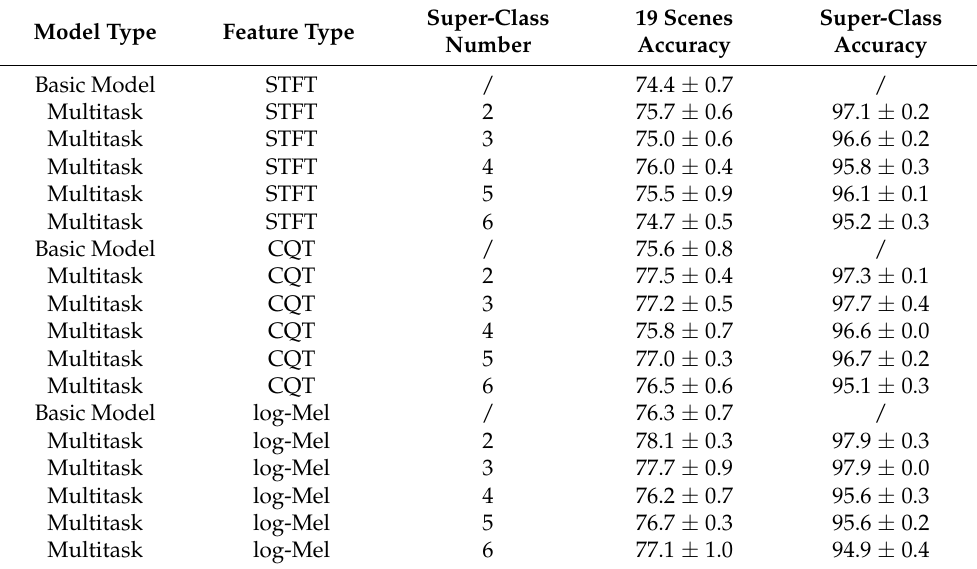
Table 5. Classification performance of the revised version of the LITIS Rouen dataset using different